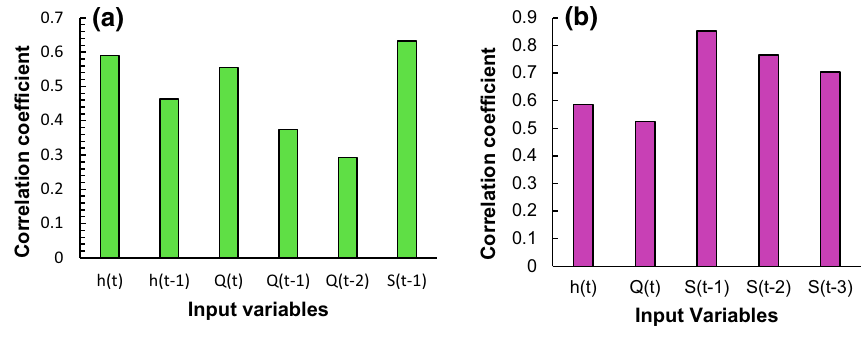
Fig. 7 Correlation graph of input variables for all dataset with output S t . at a Adityapur,